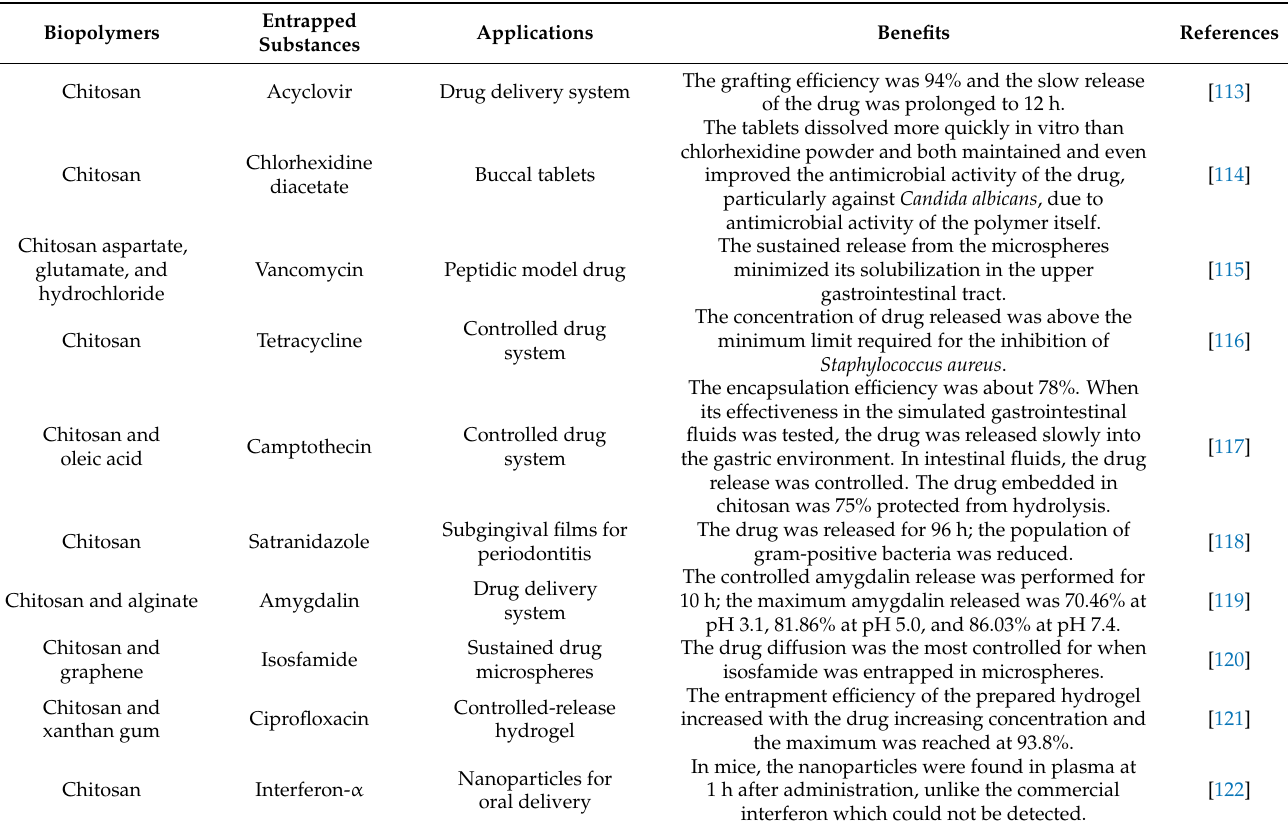
Table 3. Chitosan use for drug